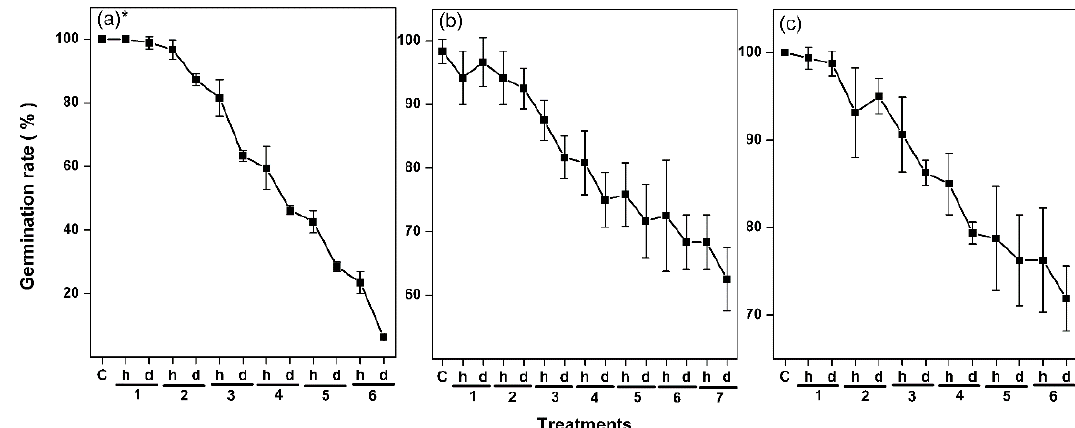
Figure 2. Effects of hydration–dehydration cycles on the germination levels of ( a ) A. thaliana seeds, ( b ) L. perenne seeds, and ( c ) N. tabacum seeds. The A. thaliana and L. perenne seeds were hydrated for 2 d and dehydrated for 5 d in each cycle, and the N. tabacum seeds were hydrated for 3 d and dehydrated for 5 d in each cycle. Germination data are mean ± SD ( n = 4 replicates, each replicate being 30 or 40 seeds). h: hydration, d: dehydration. * The A. thaliana germination levels were published previously [34].